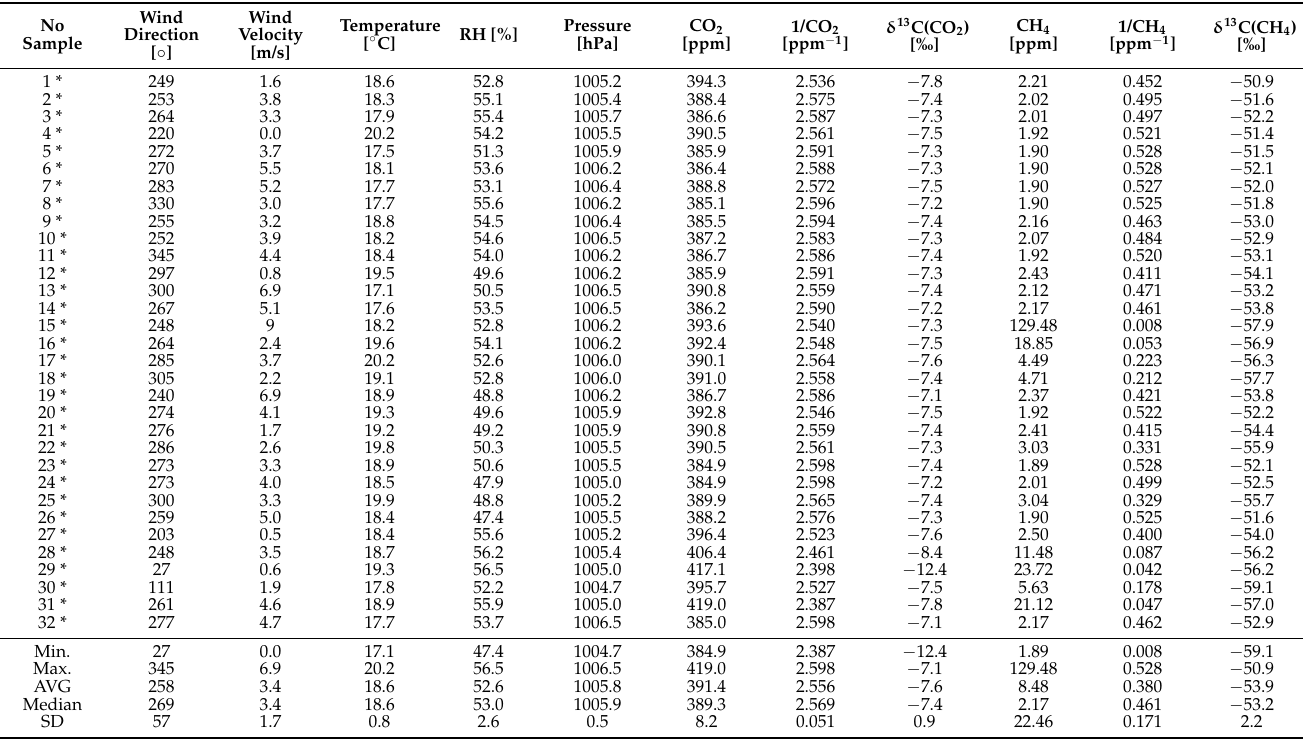
Table 2. Meteorological parameters and geochemical data of ambient air samples gathered in the vicinity of the municipal waste landfill site during the campaign on 22 August 2017.